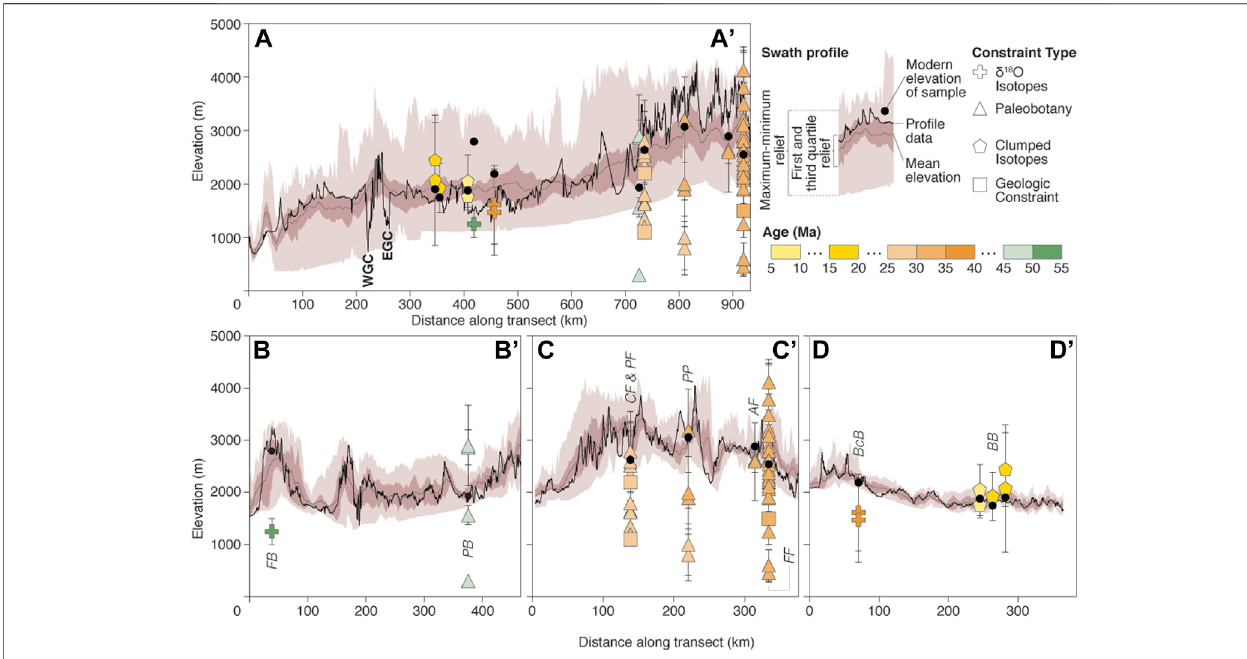
FIGURE 2 | Compilation of paleoelevation estimates for the Colorado Plateau region. Error bars shown where available and represent reported uncertainties or range of possible elevations. Symbols correspond to proxy-type and color corresponds to age (consistent with Figure 1 ). For all panels, elevation pro fi les (black line) correspondto transects in Figure 1 . Swath pro fi les ofthese transects are shown by mean elevation (gray line), the fi rstand thirdquartile relief (dark shading), and thefull maximum-minimum relief (light shading). (A) Compilation of all estimates projected onto elevation transect (A-A ’ ) ; swath pro fi le is cropped to the CP region and is 660 km across at its widest extent (330 km on either side of the transect). (B-D) Regional topographic swath pro fi les are 60 km wide (30 km on either side of the transect). Estimates are labeled by name of their geologic unit consistent with Figure 1 (BcB (cid:1) Baca Basin; BB (cid:1) Bidahochi Basin; FB (cid:1) Flagstaff Basin; PB (cid:1) Piceance Basin; CF (cid:1) Creede Formation; AF (cid:1) Antero Formation; FF (cid:1) Florissant Formation; PP (cid:1) Pitch-Pinnacle Formation; PF (cid:1) Platoro Formation). (B) Estimates from the northern plateau projected onto elevation transect B-B ’ . (C) Estimates from the present-day Rocky Mountains projected onto elevation transect (C-C ’ ) . (D) Estimates from the southern plateau projected onto elevation transect (D-D ’ ) . All data and references are presented in Supplementary Table S1 ; data from MacGinitie, 1953; Steven and Ratté, 1965; MacGinitie, 1969; Axelrod and Bailey, 1976; Meyer, 1986; Axelrod, 1987; Wolfe and Schorn, 1989; Gregory and Chase, 1992; Meyer,